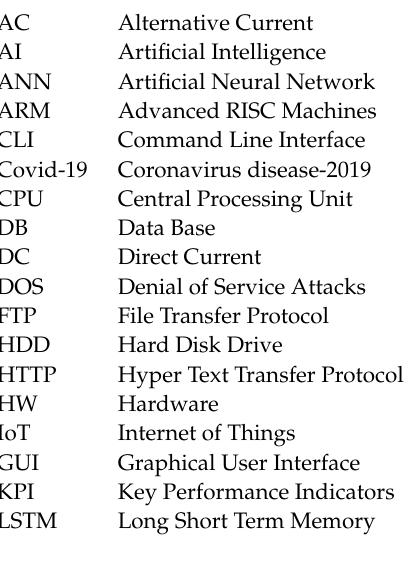
Table S3: Opex investment, Figure S2: Structure of single cell within LSM, Figure S3: Model work flow of a single cell, Figure S4: Feature selection using heat map method, Figure S5: Scatter plot of real values vs. prediction values, Figure S6: Residual plot of different time frame, Table S4: Range and percentage of deviation records, Table S5: Comparison between the proposed platform and other existing